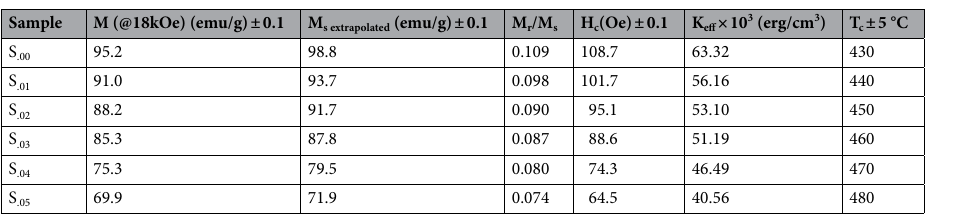
Table 2. The magnetic parameters of the uncoated samples.